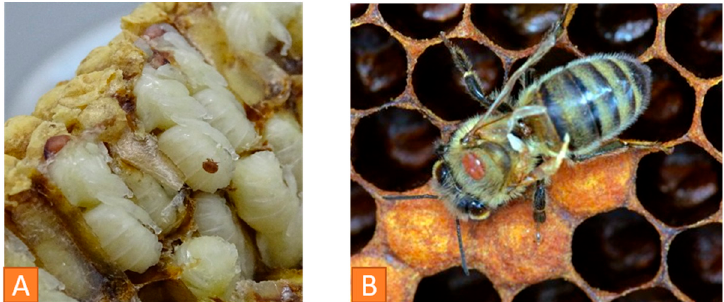
Figure 7. ( A ) Varroa infestation control via examination of drone brood: red-eyed larva with Varroa mite, © Julia Dittes. ( B ) DWV-infected adult honeybee with phoretic Varroa mites on thorax, © Ilka Emmerich.